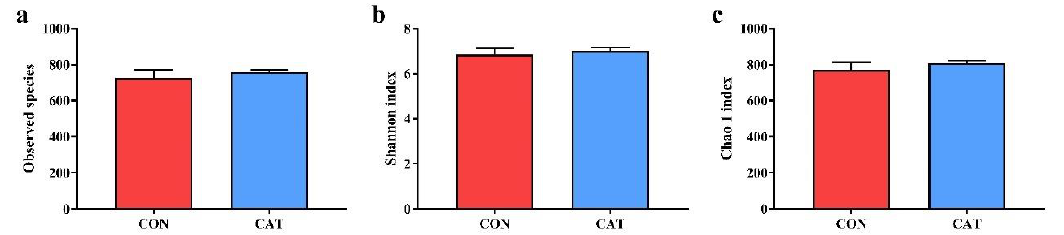
Figure 3. Difference on bacteria community diversity and richness between the two treatments. (a) Observed species; (b) Shannon index; (c) Chao 1 index. CON, piglets fed with a basal diet; CAT, piglets fed with a basal diet supplemented with 2.0 g/kg exogenous catalase production. Values are mean ± standard error ( n = 6).